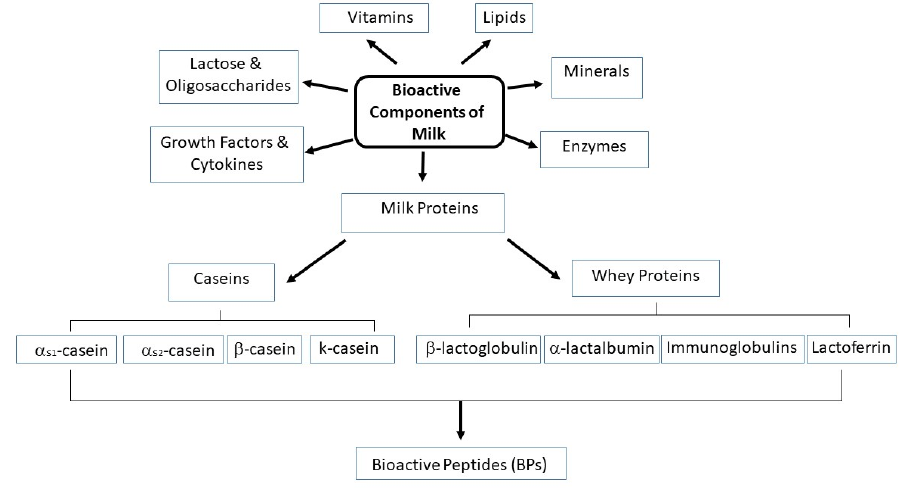
Figure 1. Major bioactive functional compounds derived from milk (adapted fom [1]).